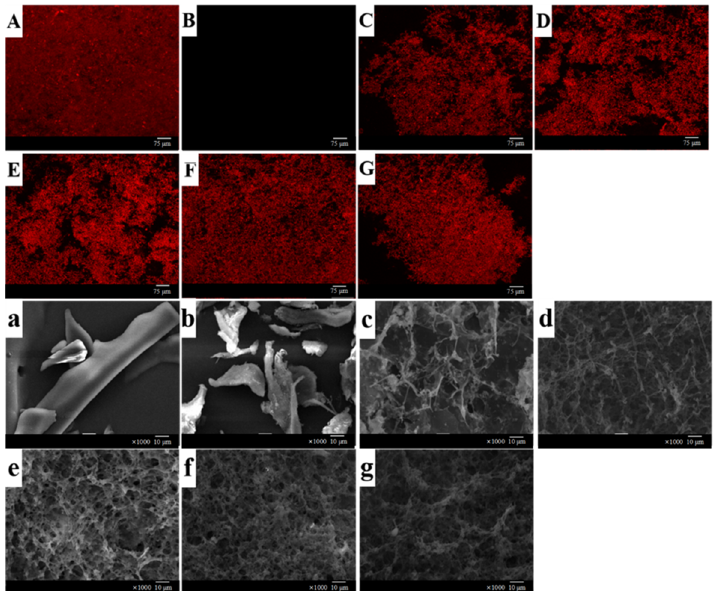
Figure 6. CLSM and SEM images of WNPI-KC composite gel samples with NaCl. ( A – G , a – g ) WNPI, KC, NaCl-0 mM, NaCl-5 mM, NaCl-10 mM, NaCl-15 mM, and NaCl-20 mM, respectively.